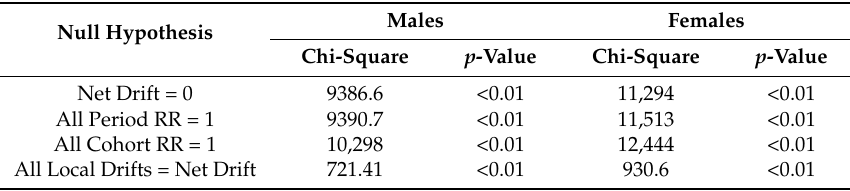
Table 1. Wald Chi-Square tests for estimable functions in the APC